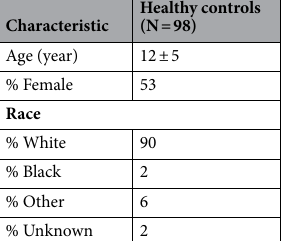
Table 3. Characteristics of the healthy subjects (N =